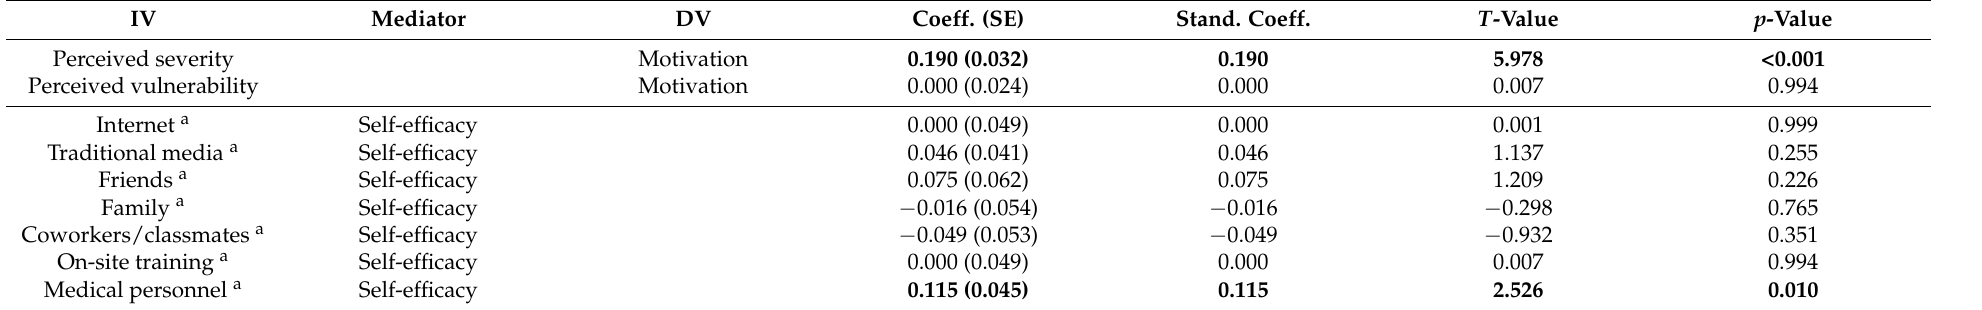
Table 4. Results of the structural equation modeling investigating the proposed